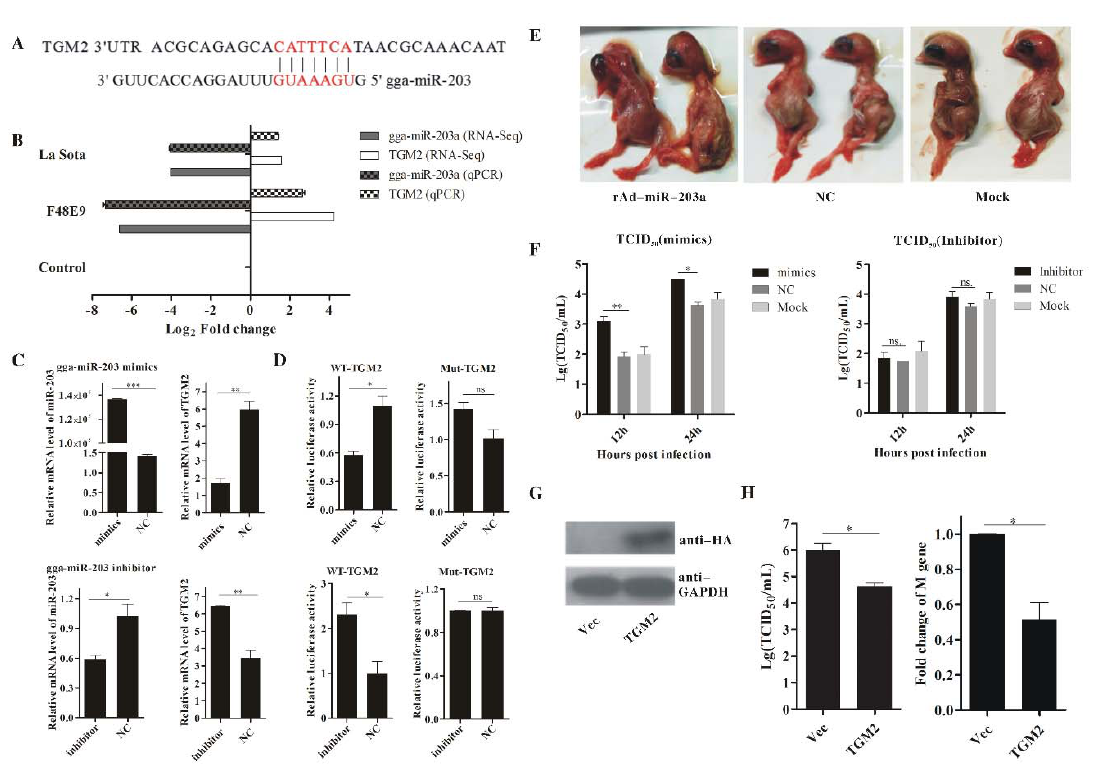
Figure 5. Regulation of transglutaminase 2 (TGM2) by gga-miR-203a and NDV replication. ( A ) Predicted binding sites of gga-miR-203a at the 3 (cid:48) UTR region in the TGM2 sequence. The red labeled sequence represents the complementary region between gga-miR-203a and the 3 (cid:48) UTR of TGM2. ( B ) RNA-Seq and RT-qPCR detected expression changes of gga-miR-203a and TGM2 during NDV infection. ( C ) RT-qPCR detected expression regulation of TGM2 by gga-miR-203a. ( D ) A luciferase activity assay detected expression regulation of TGM2 by gga-miR-203a. WT is representative of wild-type TGM2, and Mut is representative of TGM2 with mutations in the region having complementarity with the miRNA. ( E ) Clinical changes in chicken embryos submitted to rAd-miR-203, negative control (NC), or PBS infections; NC indicates rAd-miR-NC and Mock indicates treatment consisting of an injection with the same volume of PBS. ( F ) TCID 50 (50% tissue culture infection doses) detection of the viral titers of NDV in DF-1 cells treated with gga-miR-203a mimics or inhibitors. NC is the negative control, and Mock is representative of cells transfected only with the transfection reagents. ( G ) Western blot analysis detecting the expression of TGM2; Vec is representative of the empty vector. ( H ) RT-qPCR and TCID 50 detection of the viral titers of NDV in DF-1 cells with TGM2 overexpression; Vec is representative of the empty vector. The results are presented as the means ± SEM ( n = 3). The statistical analyses were performed in GraphPad Prism using unpaired 2-tailed t -tests: * p < 0.05, ** p < 0.01, *** p < 0.001, ns. indicates no significant